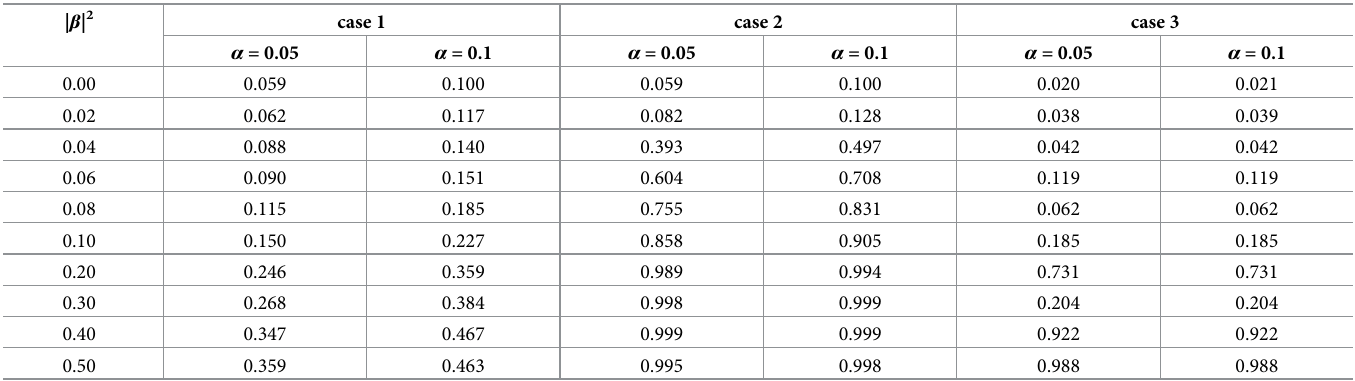
Table 1. Size and power for NP test with different searching